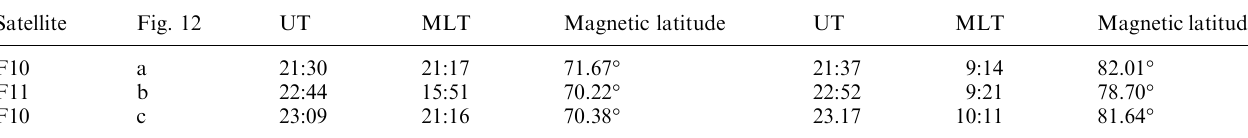
Table 1. The latitudinal position of the CRB, the local time location and the UT at which it was detected are indicated in this table, for consecutive polar passes of satellites F10 and F11 in the Northern Hemisphere